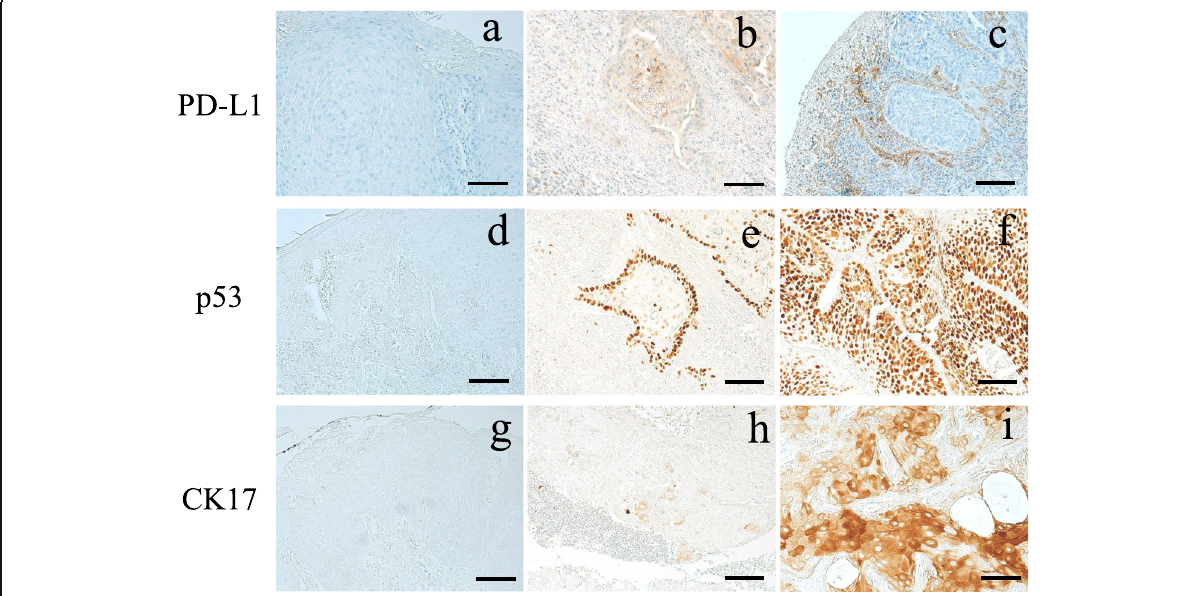
Fig. 1 Representative images of PD-L1, p53 and CK17 expression by IHC. a PD-L1 expression negative. b PD-L1 expression of TCs moderate positive. c PD-L1 expression of TILs moderate positive. d p53 expression negative. e p53 expression moderate positive. f p53 expression strong positive. g CK17 expression negative. h CK17 expression weak positive. i CK17 expression strong positive. Scale bars: 100 μ